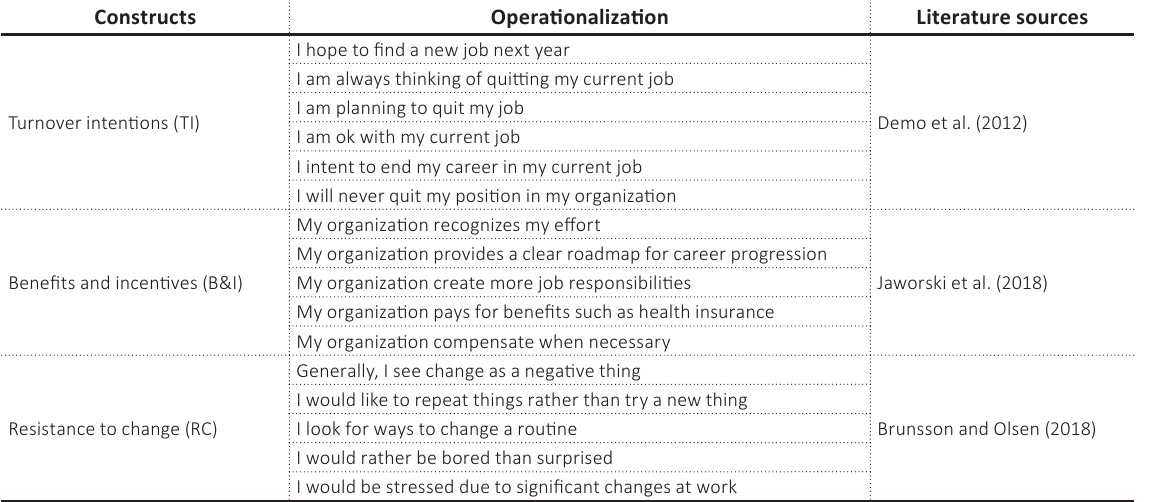
Table 2 (cont.). Construct indicators and literature sources